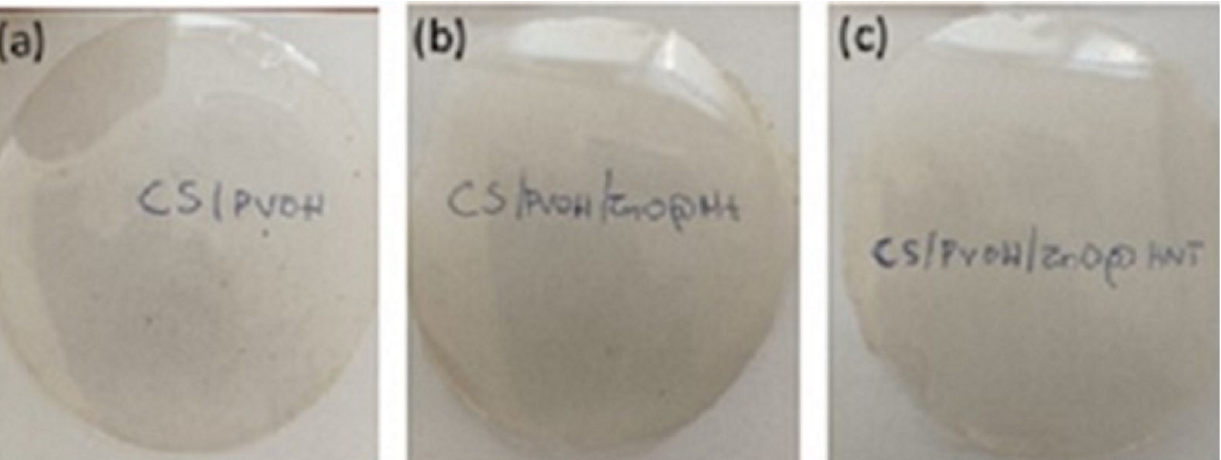
Figure 1. Representative photos of ( a ) pure CS/PVOH film and ( b ) CS/PVOH/6ZnO@Mt and ( c ) CS/PVOH/6ZnO@HNT nanocomposite